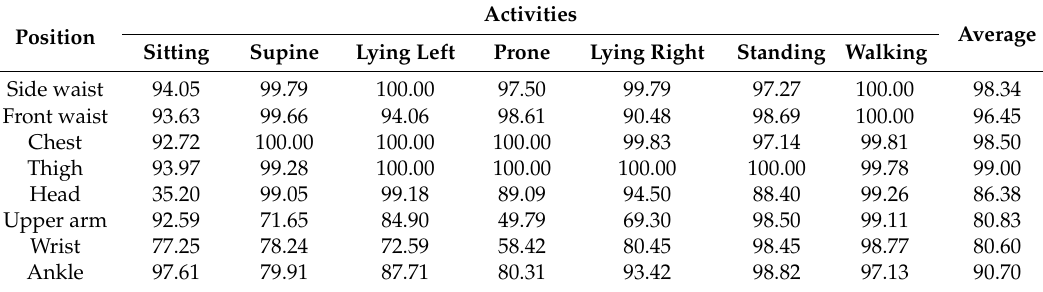
Table 5. The activities of daily living (ADL) classification results obtained from the best models on DS1.